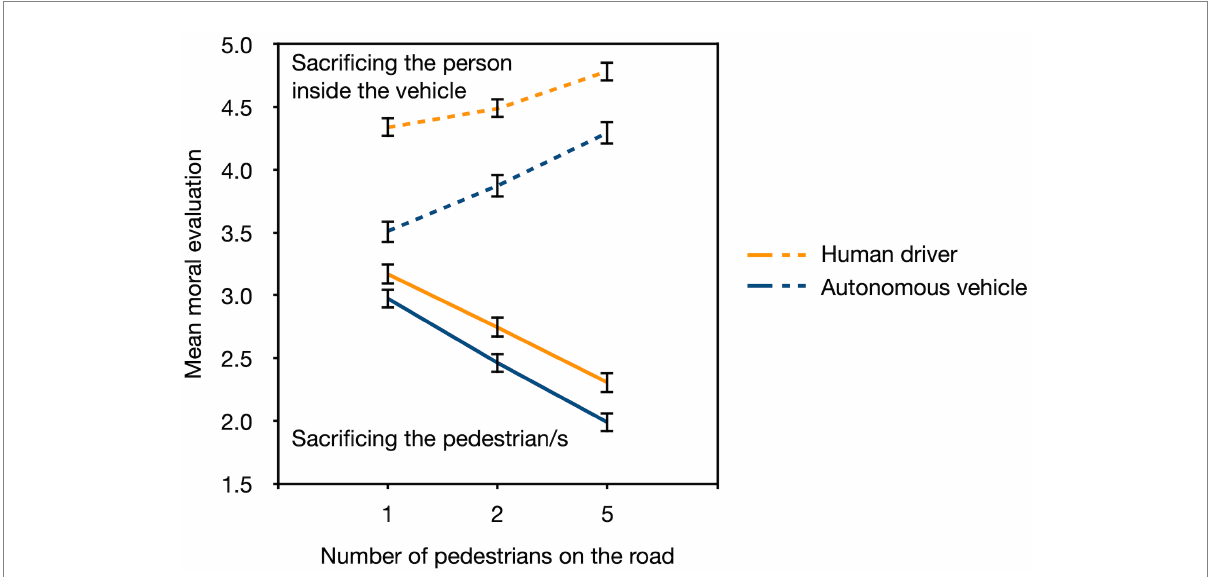
FIGURE 2 The mean moral evaluation of the actions (sacrificing the person inside the vehicle [dashed lines], sacrificing the pedestrian/s [solid lines]) as a function of the number of pedestrians on the road (1, 2, and 5) and the agent (human driver, autonomous vehicle). The moral-evaluation scale ranged from “very reprehensible” (1) to “very justifiable” (6). The error bars represent standard errors of the